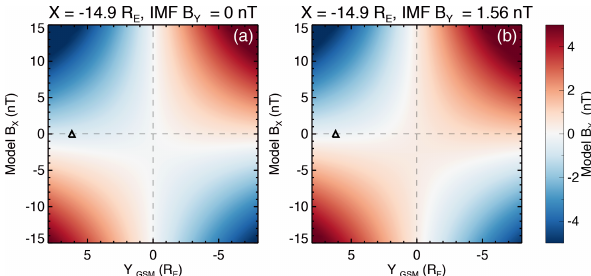
Figure 5. TA15 model magnetic field data. In each case, plotted is Y vs. B x (GSM) (at X = − 14 . 9 R E , i.e. the X position of C1 at ∼ 00:28UT on 12 October 2006), with the TA15 modelled B y value shown by the colour bar on the right. The black triangle shows the Y location of C1, at B x = 0. In panel (a) we have imposed IMF B y = 0, and for panel (b) we have used the 1h mean-averaged IMF B y ( + 1 . 56nT) in the hour prior to